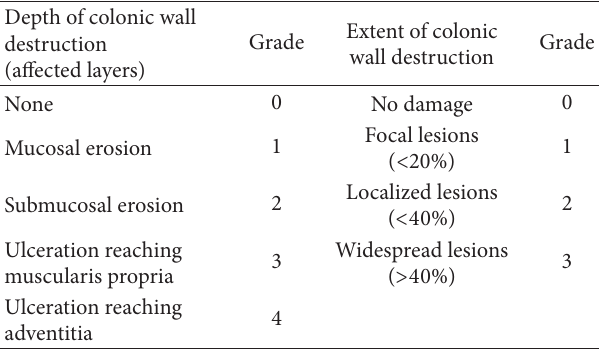
Table 1: Grading score of depth and extent of colonic wall destruc-